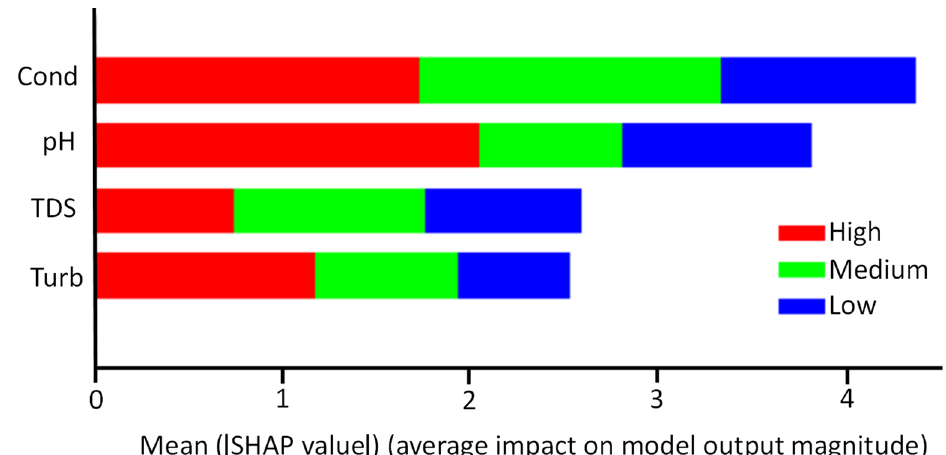
Figure 7. SHAP feature importance plot for different arsenic concentrations.